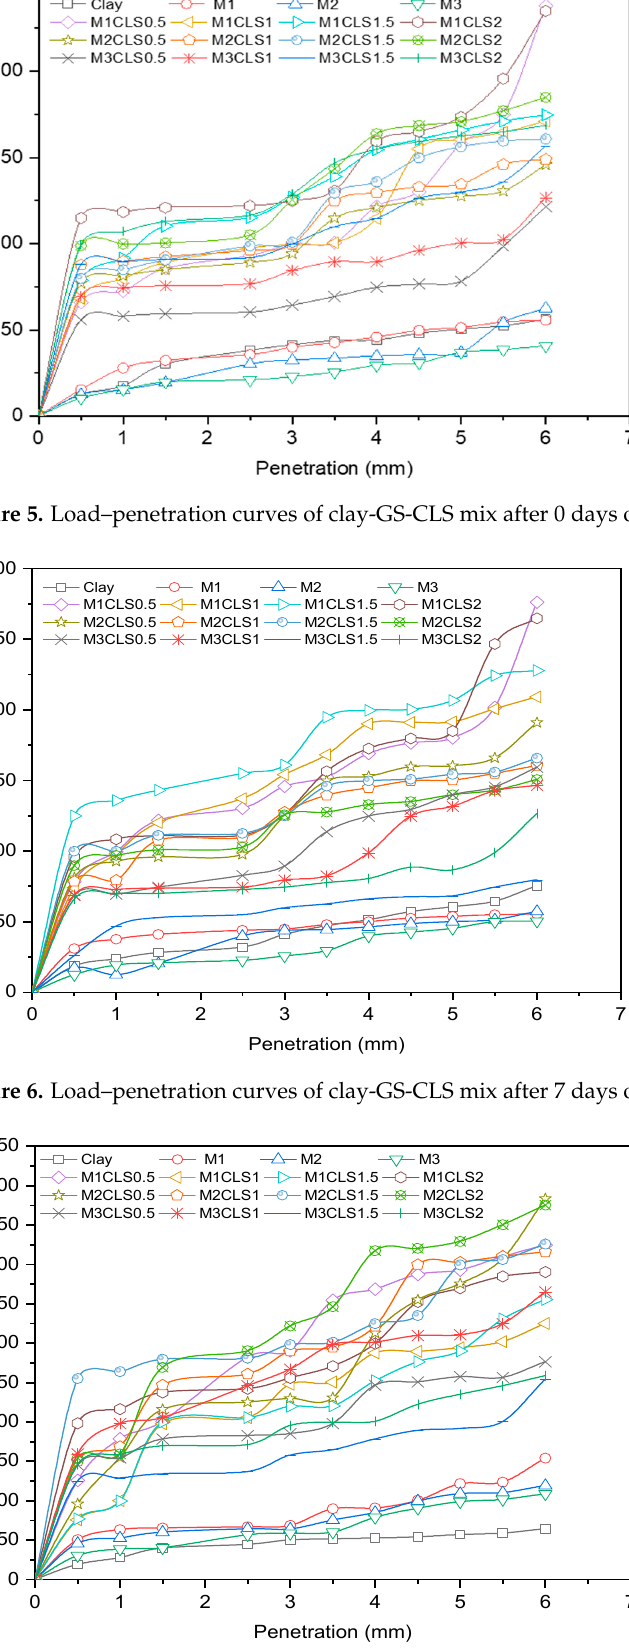
Figure 7. Load–penetration curves of clay-GS-CLS mix after 28 days curing.